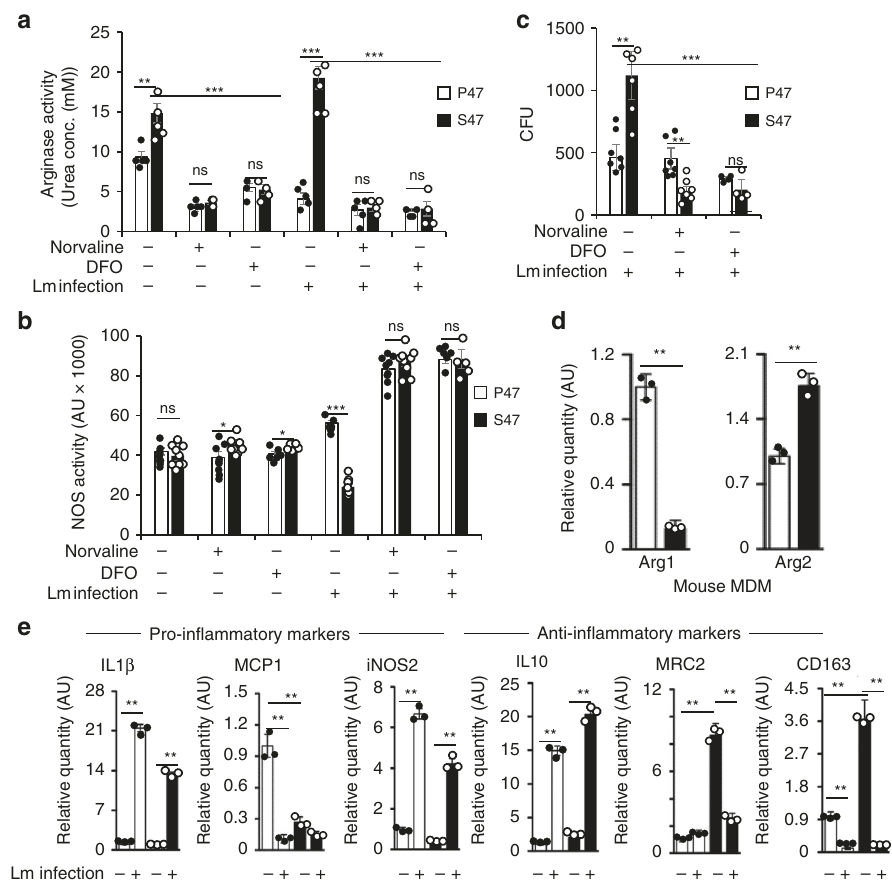
Fig. 5 S47 mouse macrophages exhibit anti-in fl ammatory response to Lm infection. a Arginase activity, b NOS activity, and c bacterial CFU, measured in P47 (white) and S47 (black) under indicated conditions ( n = 5 biological replicates and three technical replicates). Error bars represent means ± s.e.m. *** P < 0.001, ** P < 0.01, * P < 0.05, ns — not signi fi cant; by unpaired Student ’ s t test, relative to P47 mice or to S47 mice where indicated. d Relative expression data of Arg1 and Arg2 by qRT-PCR analyses of male P47 (white) and S47 (black) mouse MDMs. Error bars represent means ± s.e.m. n = 3, ** P < 0.01,